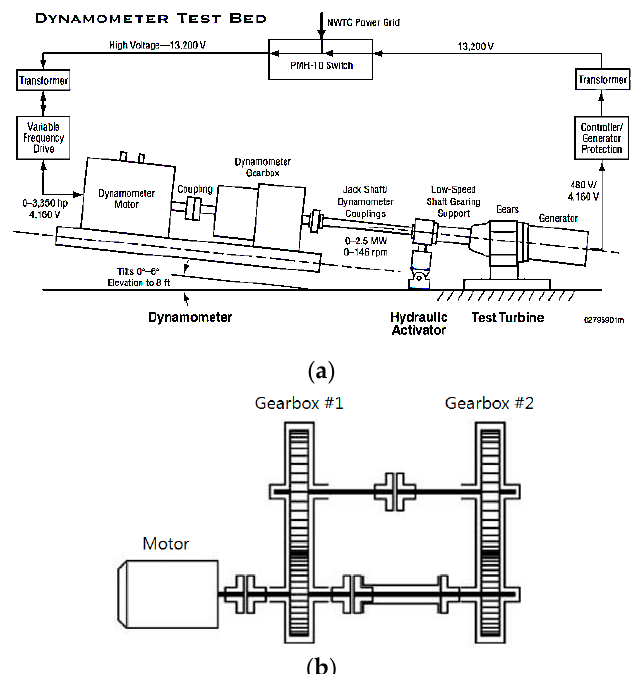
Figure 1. Power circulation test rig for a wind turbine gearbox (WTGB). ( a ) Electrical type. ( b ) Figure1. Powercirculationtestrigforawindturbinegearbox(WTGB).( a )Electricaltype. ( b Mechanical type.